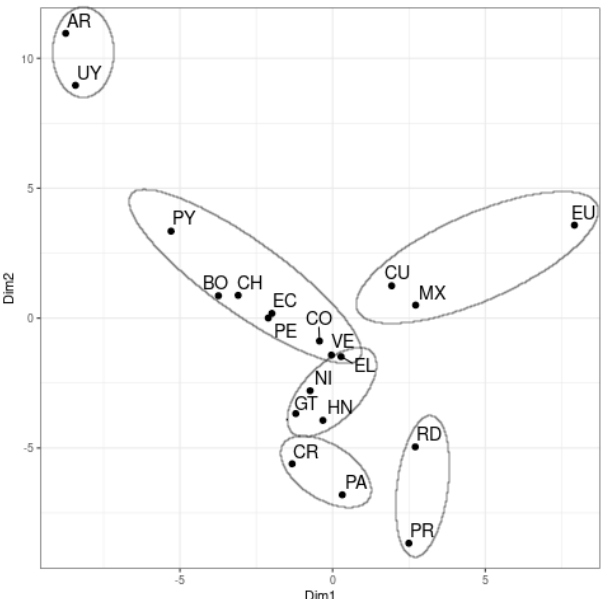
Figure 7. PCA Plot Using the 123 Highest Ranked SVM Features that Correlated with the 7 Proposed Dialect Areas